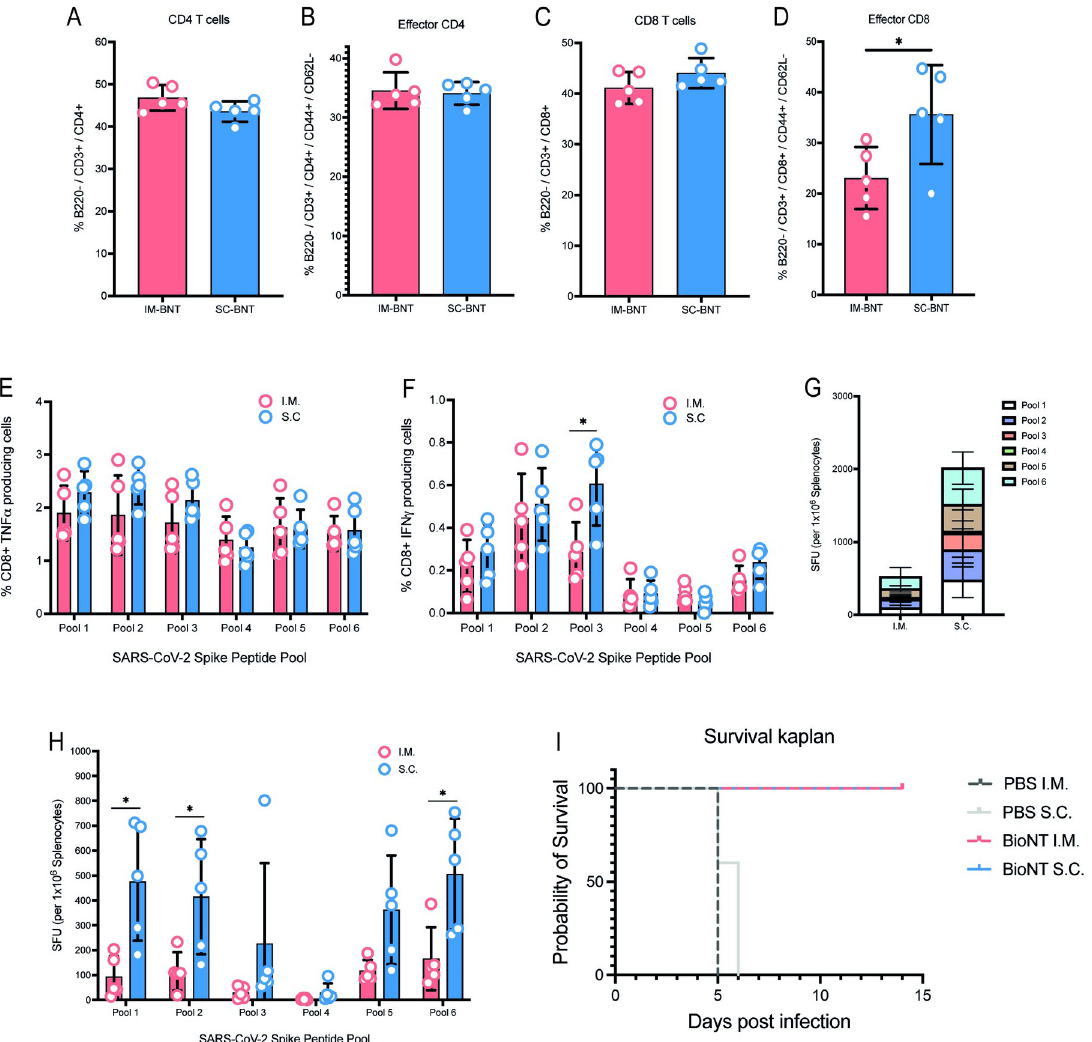
Fig 8. Superior T-cell responses generated after 2 doses of s.c. and i.m. BNT162b2 vaccination. (A–D) CD4 + (A), effector CD4 + (B), CD8 + (C) and effector CD8 + (D) cells were assessed in spleens of vaccinated animals with surface staining for T-cell markers via flow cytometry. (E, F) TNF α CD8 + T cells (E) and IFN γ + CD8 + T cells (F) in spleens of immunized mice 10 days postdose 2 were assessed after ex vivo stimulation with pooled Spike protein peptides and subsequent intracellular staining. (G, H) SARS-CoV-2 spike protein- specific responses to pooled Spike protein peptides were assessed with IFN γ ELISpot assay 10 days postboost. (I) Kaplan–Meier survival curve of animal challenged with live SARS-CoV-2 12 days following second dose of vaccination. Data presented as means ± SD. In vivo experiments were conducted with a minimum of n = 5 per group. Unpaired Student t test was used for experiments comparing 2 groups. � P < 0.05. Data underlying this figure can be found in S1 Data. IFN γ , interferon gamma; i.m., intramuscular; SARS-CoV-2, Severe Acute Respiratory Syndrome Coronavirus 2; s.c., subcutaneous; TNF α , tumor necrosis factor